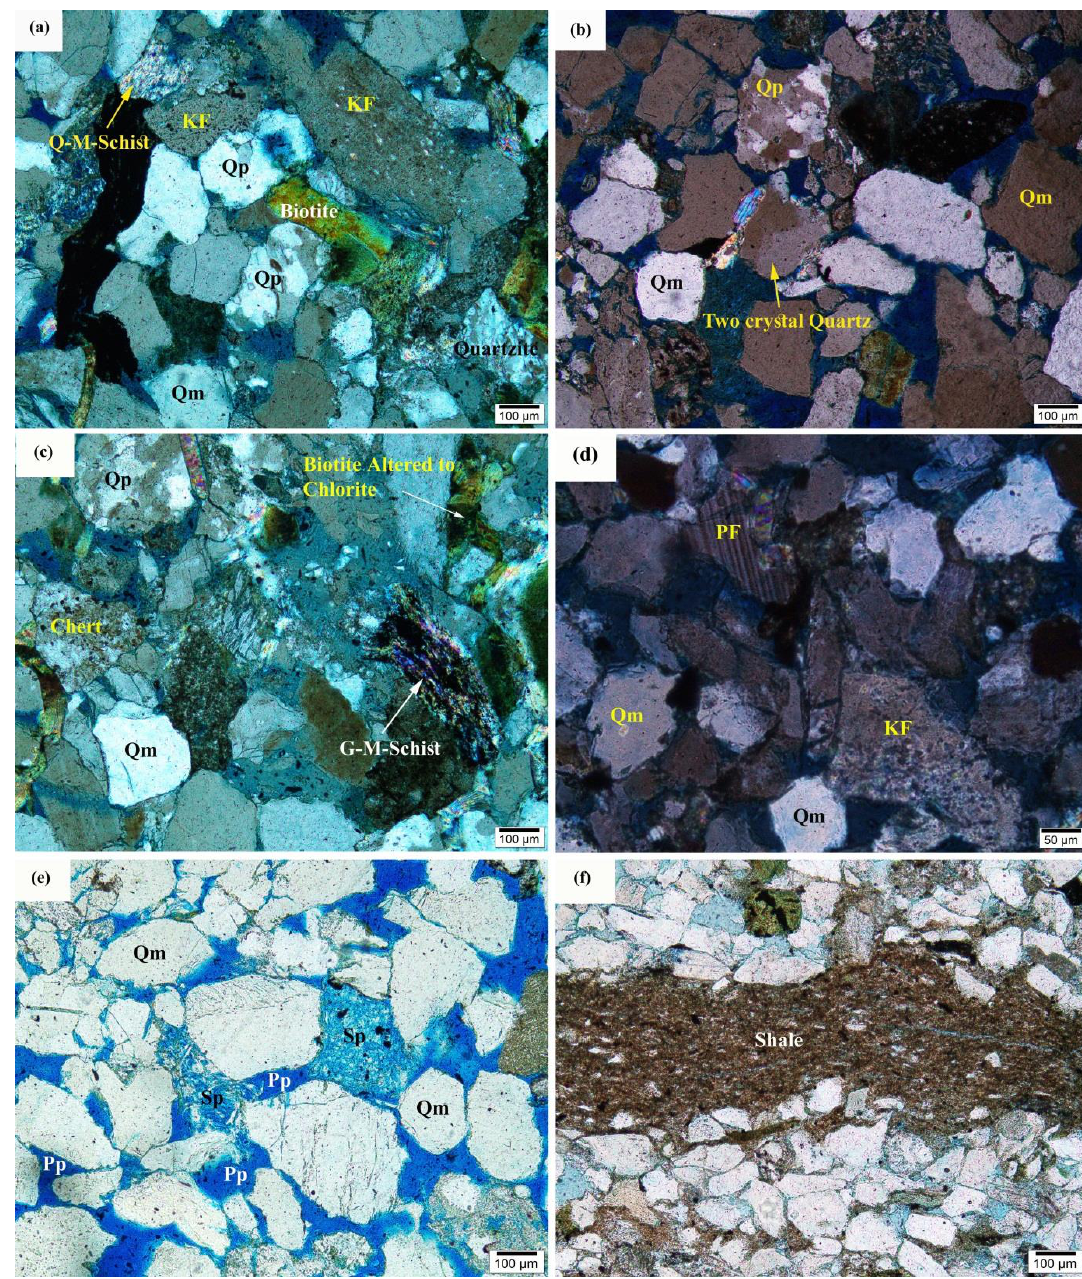
Figure 4. Photomicrographs of the Srikail-3 well: ( a ) showing metamorphic lithic grain (Quartz-mica-Schist, Q-M-Schist), monocrystalline quartz, Qm, polycrystalline quartz, Qp, Potassium feldspar, KF, depth 3182 m; ( b ) monocrystalline quartz, Qm, polycrystalline quartz, Qp, blue areas (pore spaces) depth 3180 m; ( c ) showing metamorphic lithic grain (Quartz-mica-Schist, Q-M-Schist), monocrystalline quartz, Qm, polycrystalline quartz, Qp, chert, biotite being altered to chlorite-depth 3182; ( d ) showing monocrystalline quartz, Qm, Potassium feldspar, KF, Plagioclase feldspar, PF-depth 3089 m; ( e ) showing monocrystalline quartz, Qm, Primary porosity (Pp), Secondary porosity (Sp), depth 3183.5 m; ( f ) shows shale interlayering within sandstone—depth 3088 m. According to Folk’s (1974) [17] categorization, the sandstones of the Srikail-3 well are mainly of sublitharenite to feldspathic litharenite (Figure 5a) and by McBride’s classification (1963) [18], the sandstones are of sublitharenite to subarkosic, while a few are quartz arenite (Figure 5b) in nature.